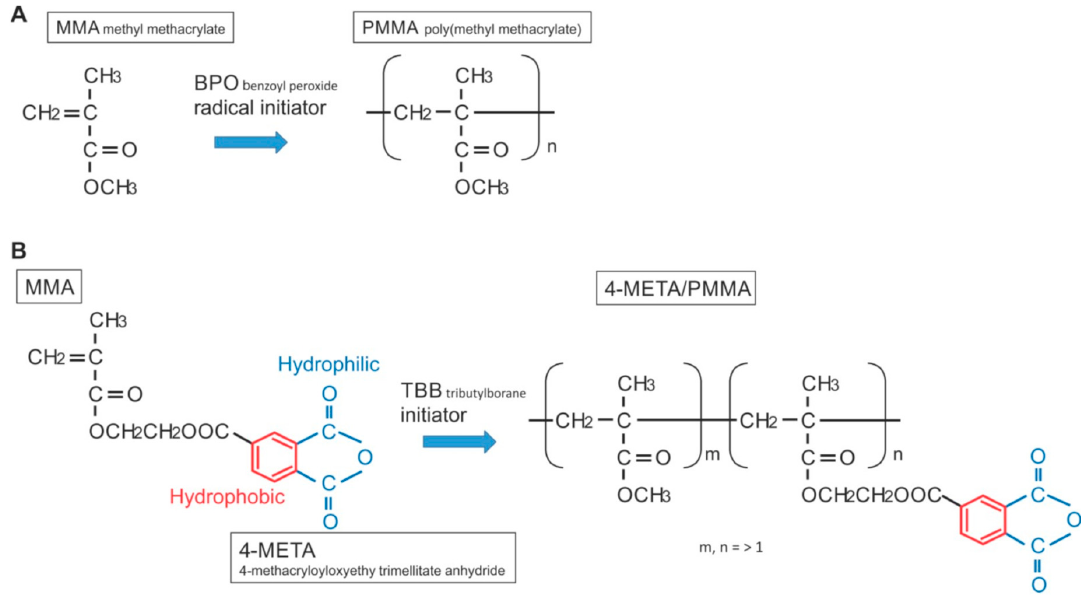
Figure 13. Structure and chemical formula during polymerization of PMMA-BPO and 4- Structure and chemical formula during polymerization of PMMA-BPO and META/MMA-TBB materials used in this study. 4-META / MMA-TBB materials used in this